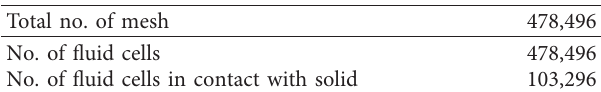
Table 4: Simulation condition of fine meshing with manual time step.